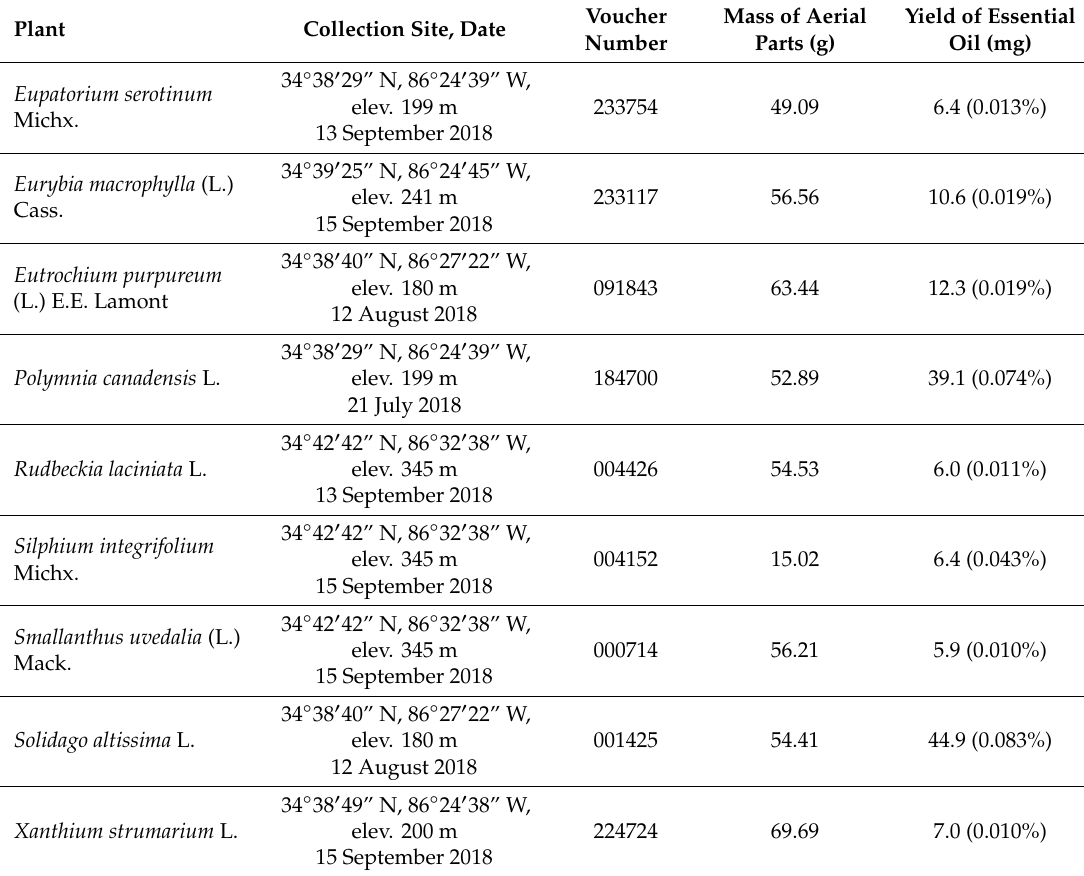
Table 14. Plant collection sites and essential oil yields of Asteraceae from north Alabama.